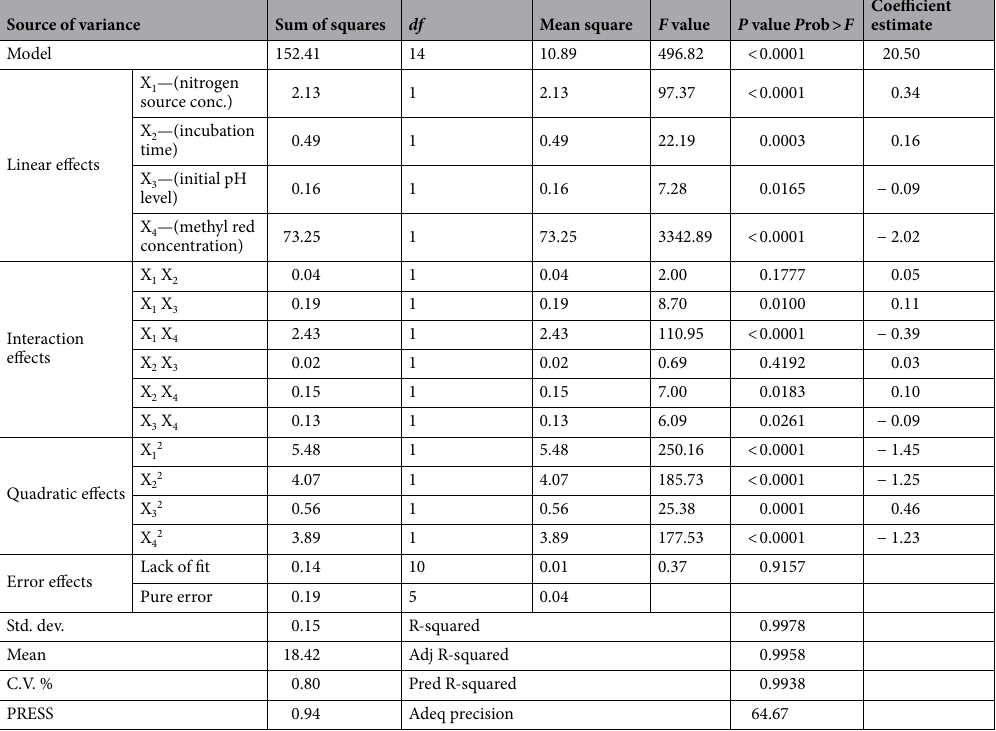
Table 3. ANOVA for FCCCD results for lipid production (%) by using Scenedesmus obliquus